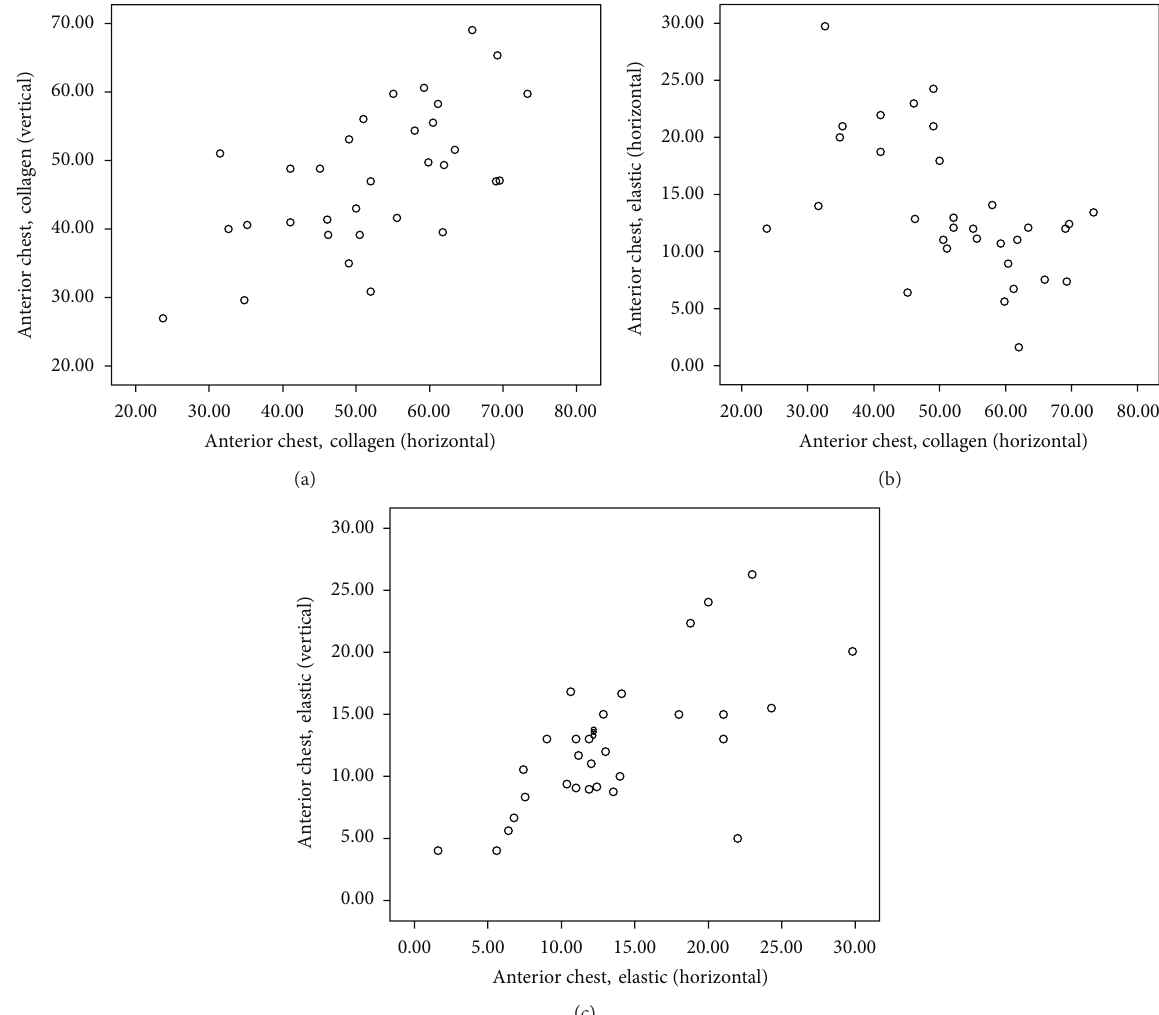
Table 3: Significant Spearman coefficient ( 𝑟 ) and pattern of correlation trend profile.